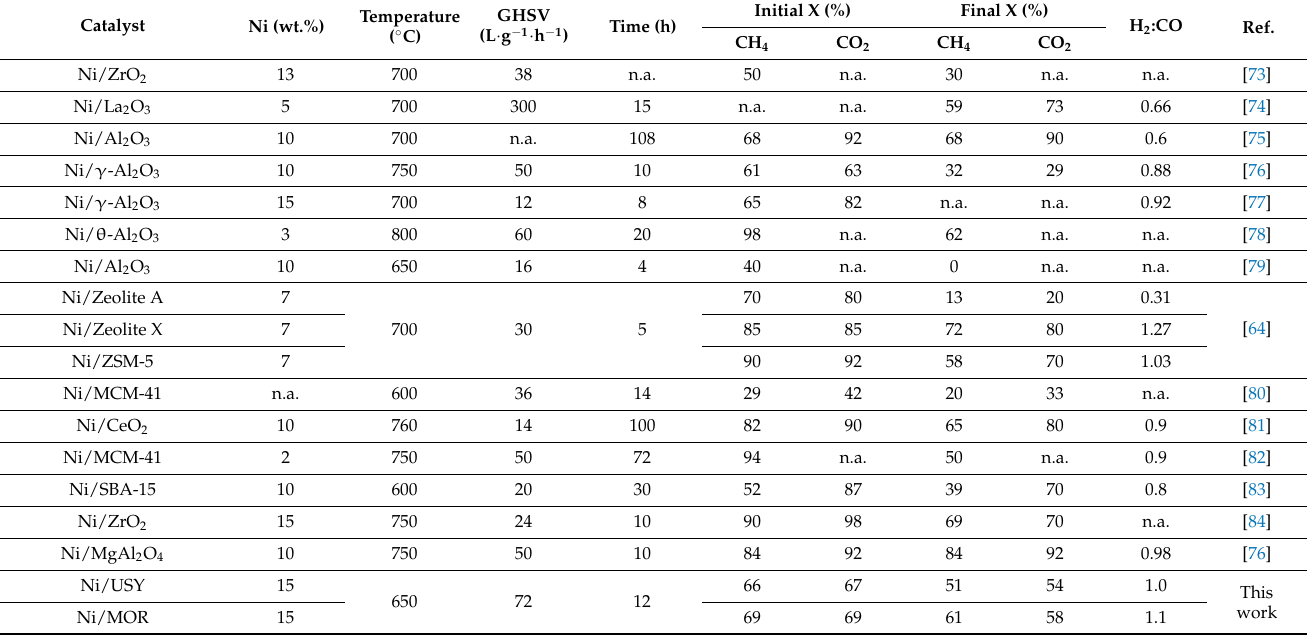
Table 4. Comparison of the most outstanding catalysts from this work with others from literature.